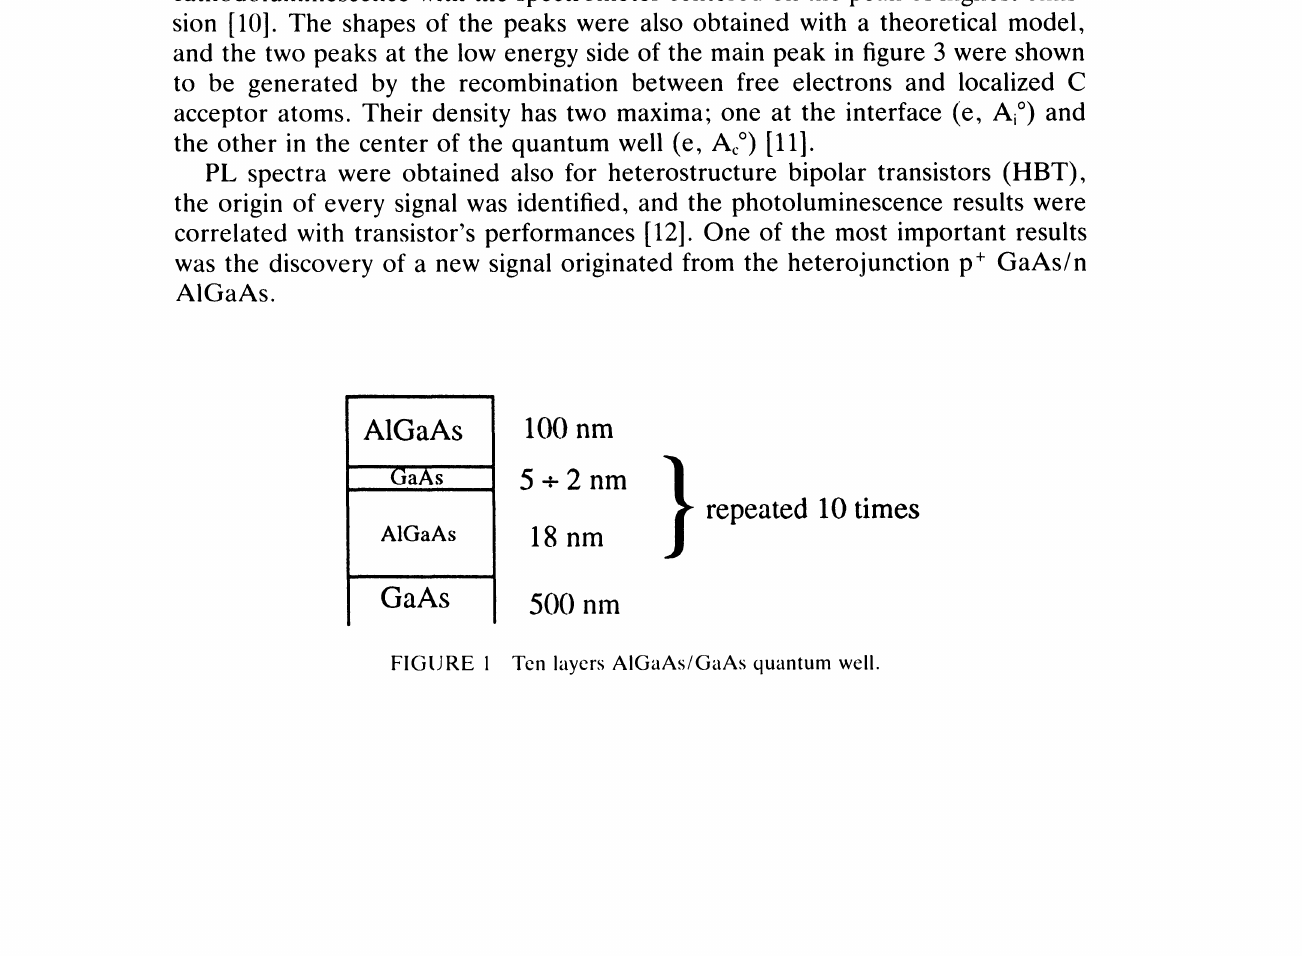
FIGIJRE Ten layers AIGaAs/GaAs quantum